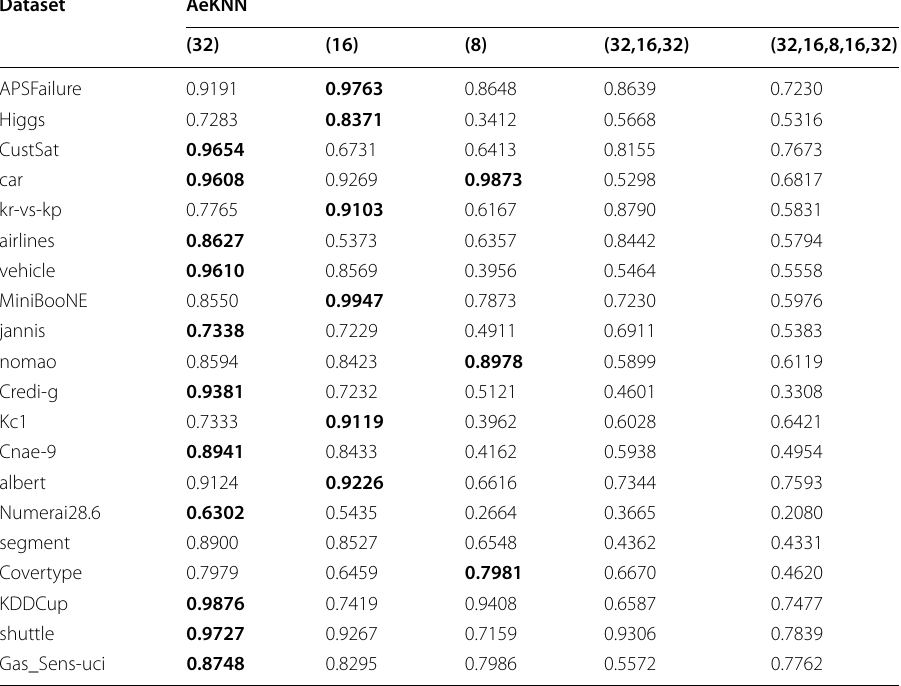
The best ones are highlighted in bold